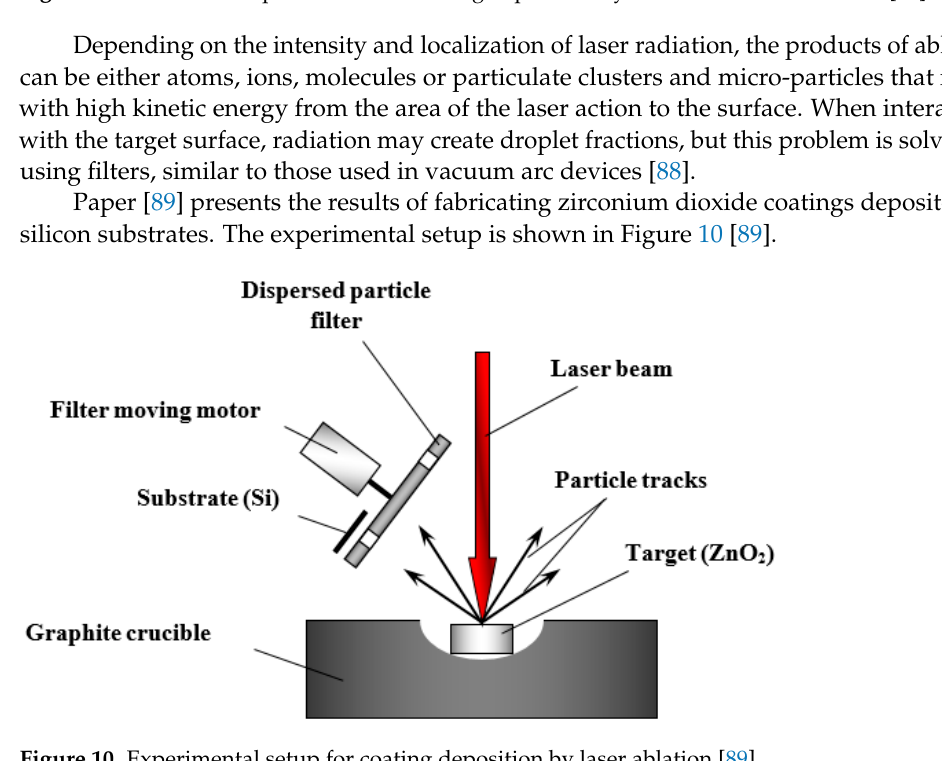
Figure 9. Schematic setup for dielectric coating deposition by the laser ablation method [87].